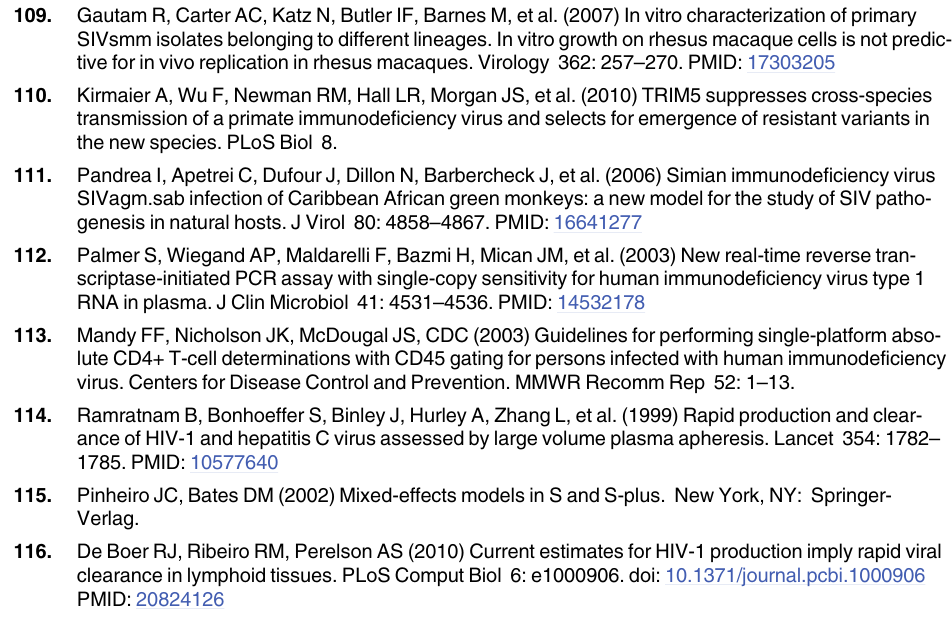
PLOS Pathogens | DOI:10.1371/journal.ppat.1005879 September 15,